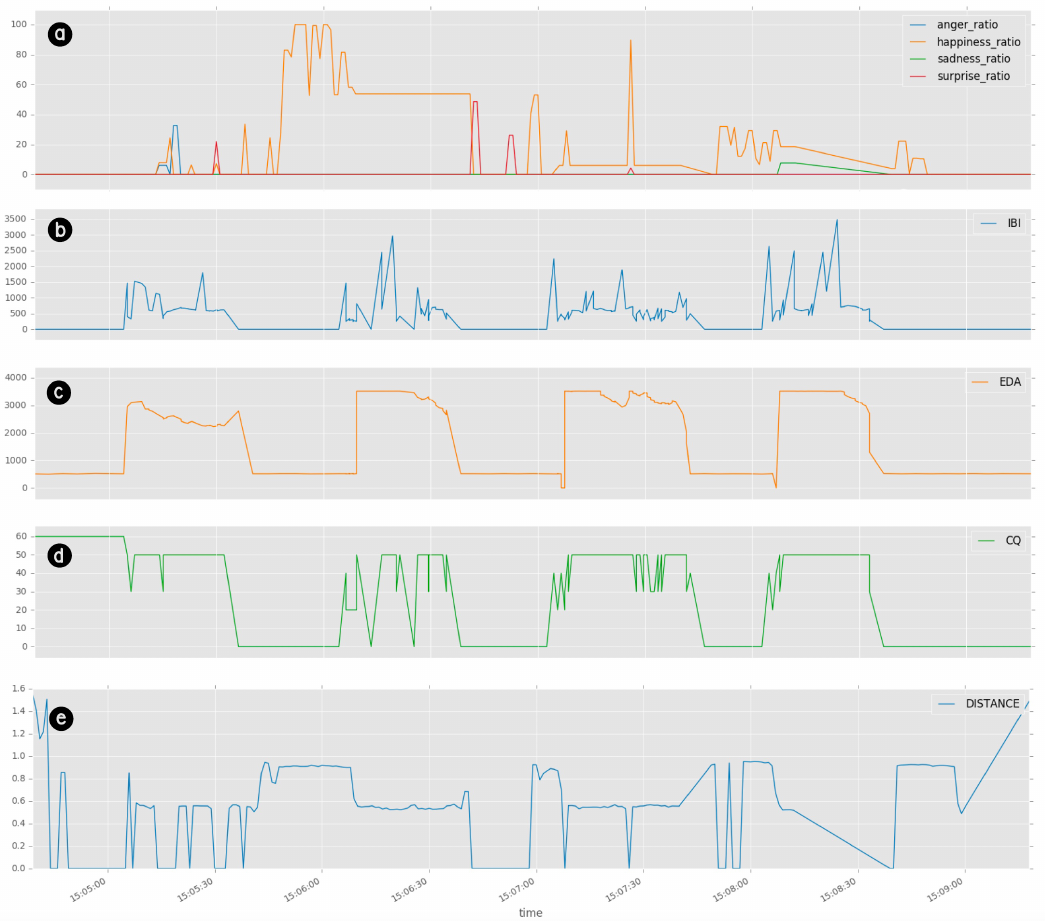
Figure 11. Data extracted from the database about: ( a ) facial expression estimation (expression ratio); ( b ) Inter-Beat Interval (IBI); ( c ) Electro Dermal Activity (EDA); ( d ) Contact Quality (CQ); ( e ) distance